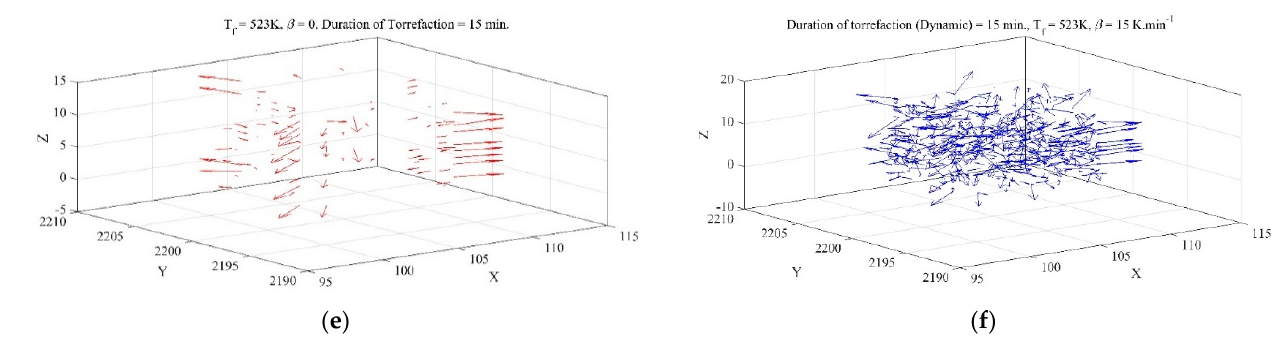
Figure 6. Thermal gradient across the biofuel pellet ( a , c , e ): quasi-static; ( b , d , f ): dynamic ( g = 0, q = 1.430 W · m − 2 · K − 1 , k = 3.056 W · m − 1 · K − 1 , Re = 798.85, Pr = 0.0001988).